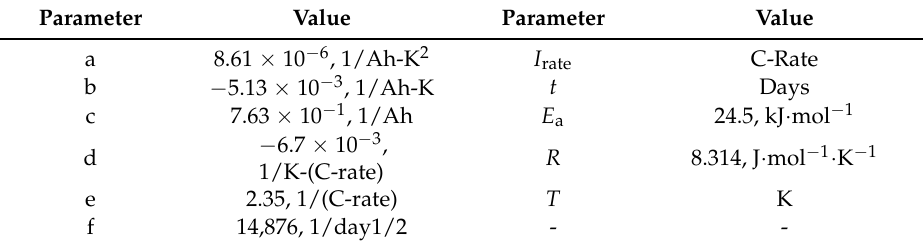
Table 7. Parameter